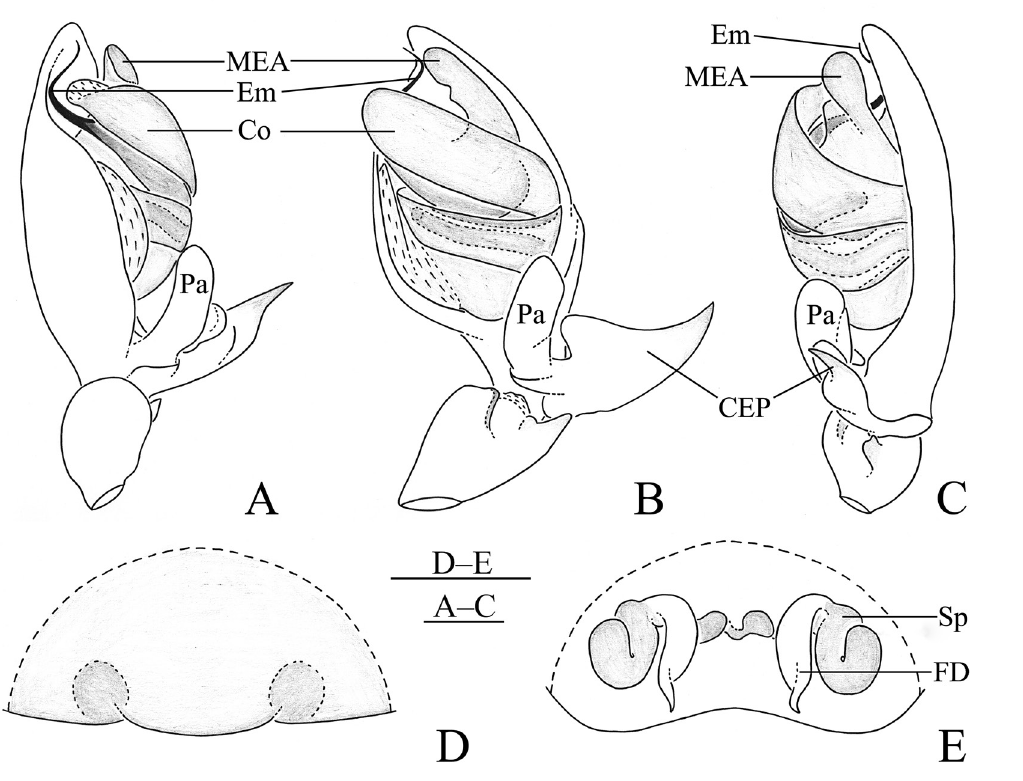
Fig. 9. Meta tangi sp. nov. Left palp of holotype ♂ (A–C); epigyne (D) and vulva (E) of paratype ♀ (HNU-20071010) . A . Prolateral view. B . Ventral view. C . Retrolateral view. D . Epigyne, ventral view E . Vulva, front view. Scale bars: 0.2